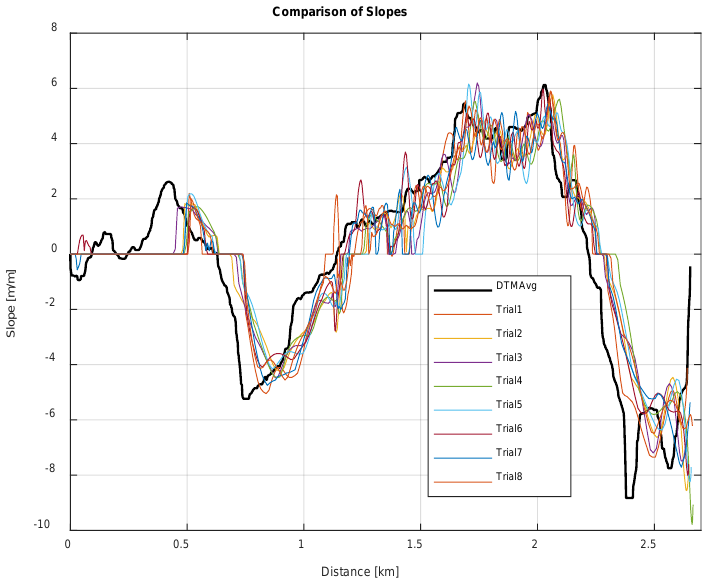
Figure 17. Slope averaging using median filter.